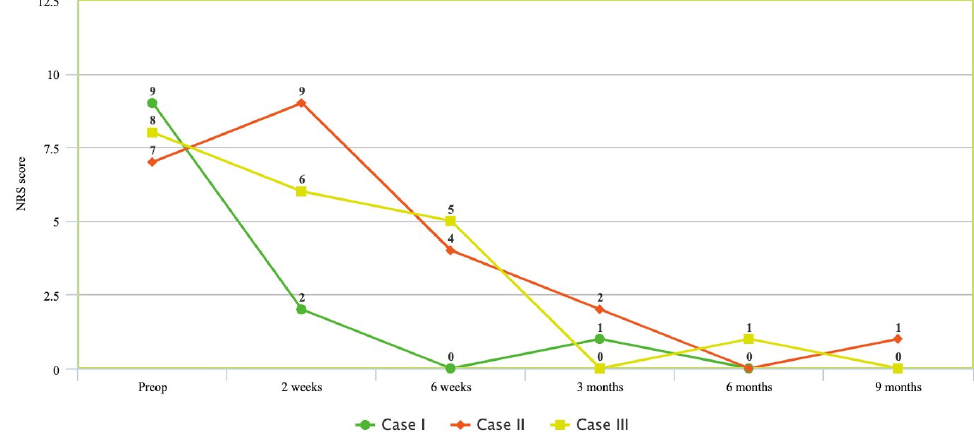
Figure 1. Numeric rating scale (NRS) changes over time for patients pre-operatively and at 2-week, 6-week, 3-month, 6-month, and 9-month follow-up.